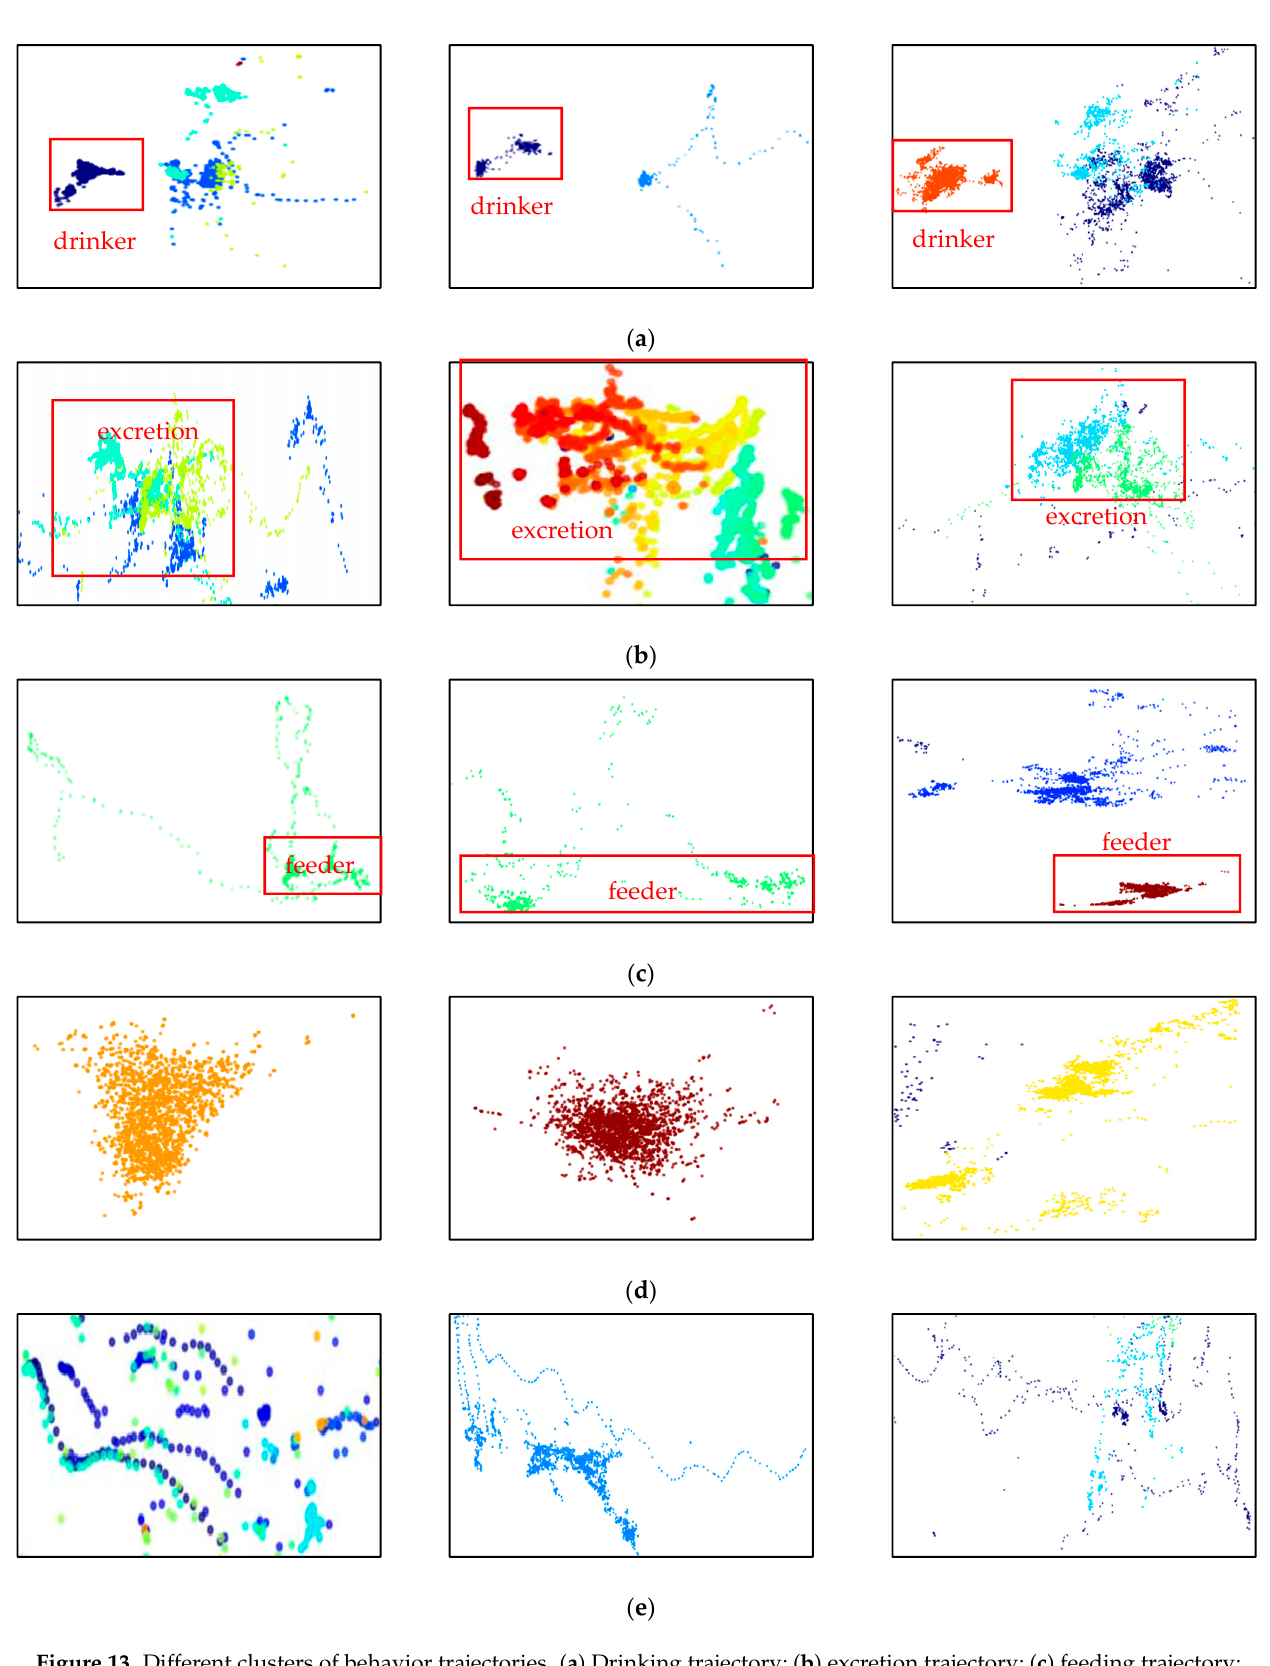
Figure 13. Different clusters of behavior trajectories. ( a ) Drinking trajectory; ( b ) excretion trajectory; ( c ) feeding trajectory; ( d ) resting trajectory; ( e ) standing